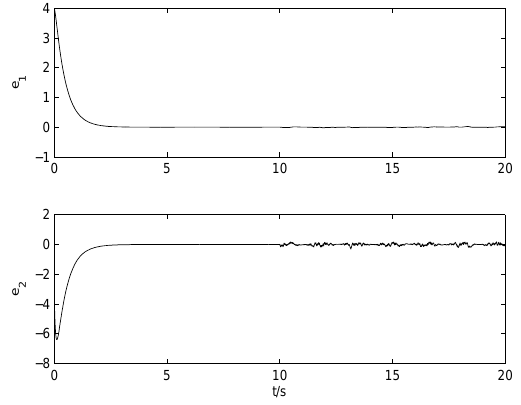
Figure 6: Time response of error variable of second order master-slave